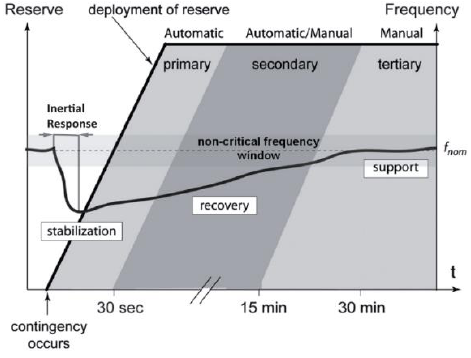
Figure 1. A. Frequency response stages as described in [29].